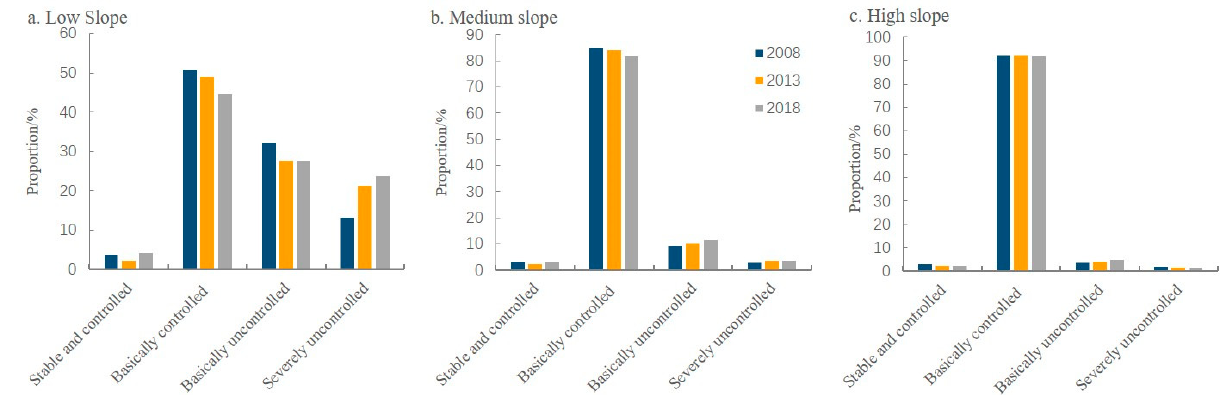
Figure 6. Changes in the degree of land-use conflict in areas with different slopes in Lin’an District, 2008–2018. ( a ) Low slope. ( b ) Medium slope. ( c ) High slope.